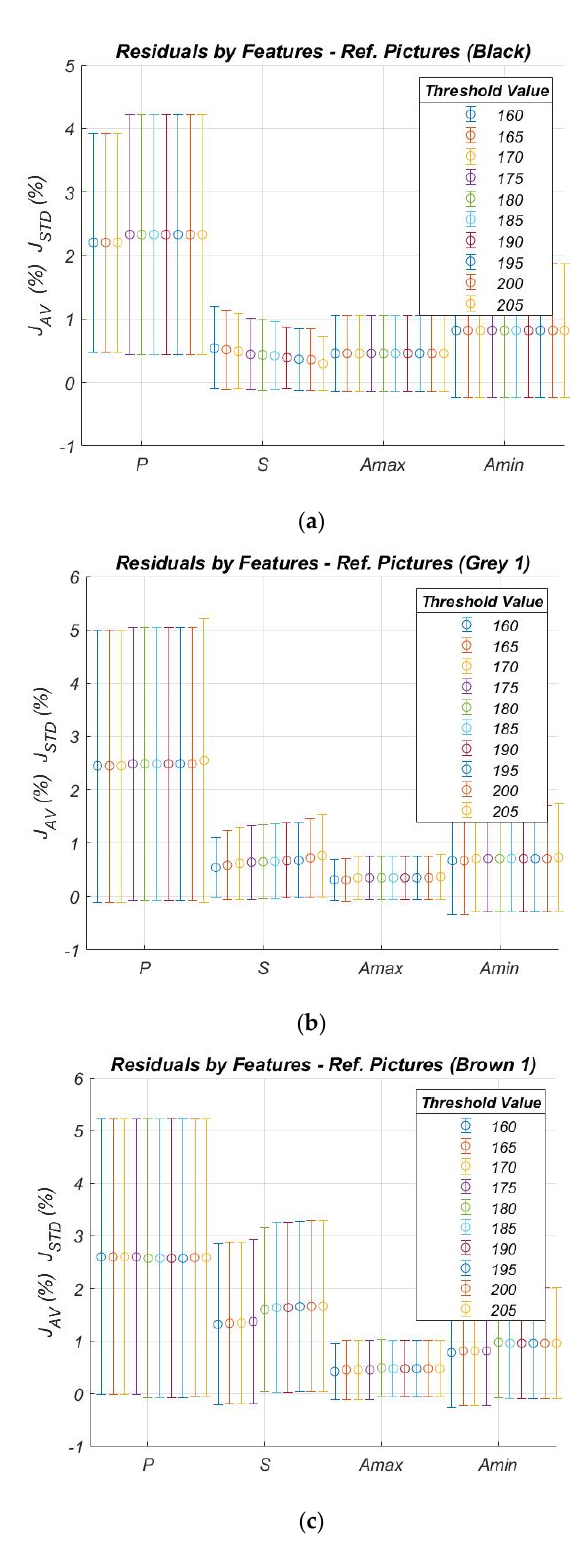
Figure 7. Results obtained for the reference picture “Brown 1”, in terms of mean values (Index (5)) and standard deviations (index (6)) of the performance Indexes (1)–(4), estimated for each particle core characteristic. ( a ) Black, ( b ) Grey 1, ( c ) Brown 1.